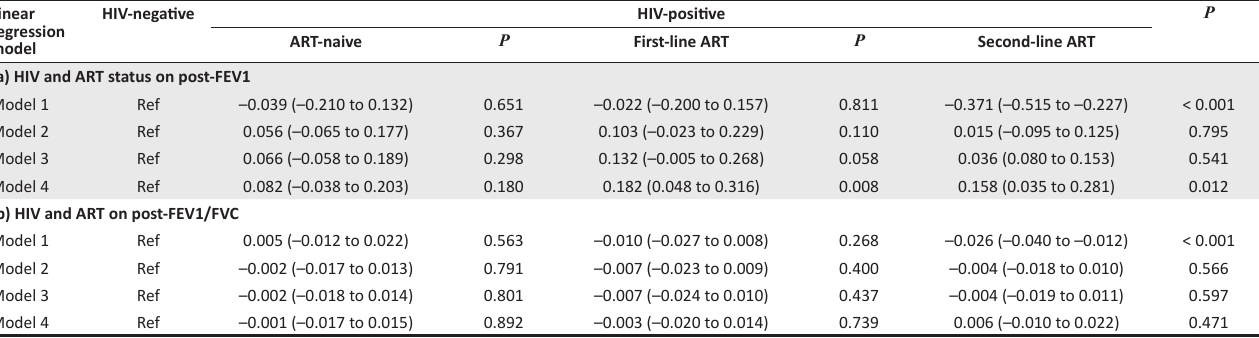
TABLE 3: HIV and antiretroviral therapy status on mean (a) post-forced expiratory volume in 1 s and (b) post-forced expiratory volume in 1 s/forced vital capacity. Linear regression model